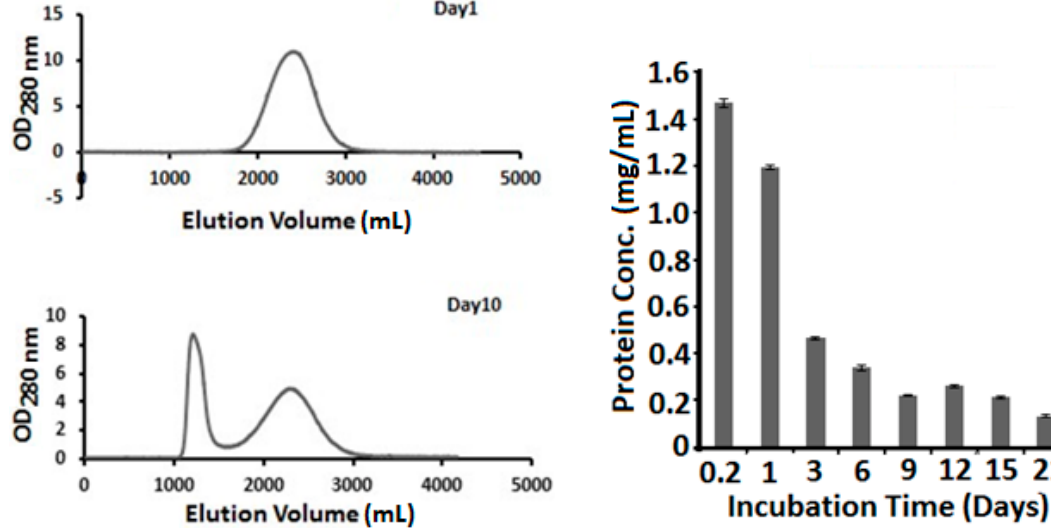
Figure 2. Non-fibrous lysozyme. As fibers and gel are formed, a substantial amount of lysozyme remains in non-fibrous form. (Left Panel) fast protein liquid chromatograpy (FPLC) analysis of soluble non-fibrous lysozyme. After centrifugation to remove fibers from the amyloid fiber solution, supernatant was analyzed by FPLC. The peak eluted at around 1200 mL from the column is thought to be the colloidal peak, consisting mostly spheres and very short fibers. The peak eluated at around 2300 mL is thought to be lysozyme monomers. (Right Panel) Non-fibrous lysozyme concentrations were measured for lysozyme fiber reactions harvested at different times.